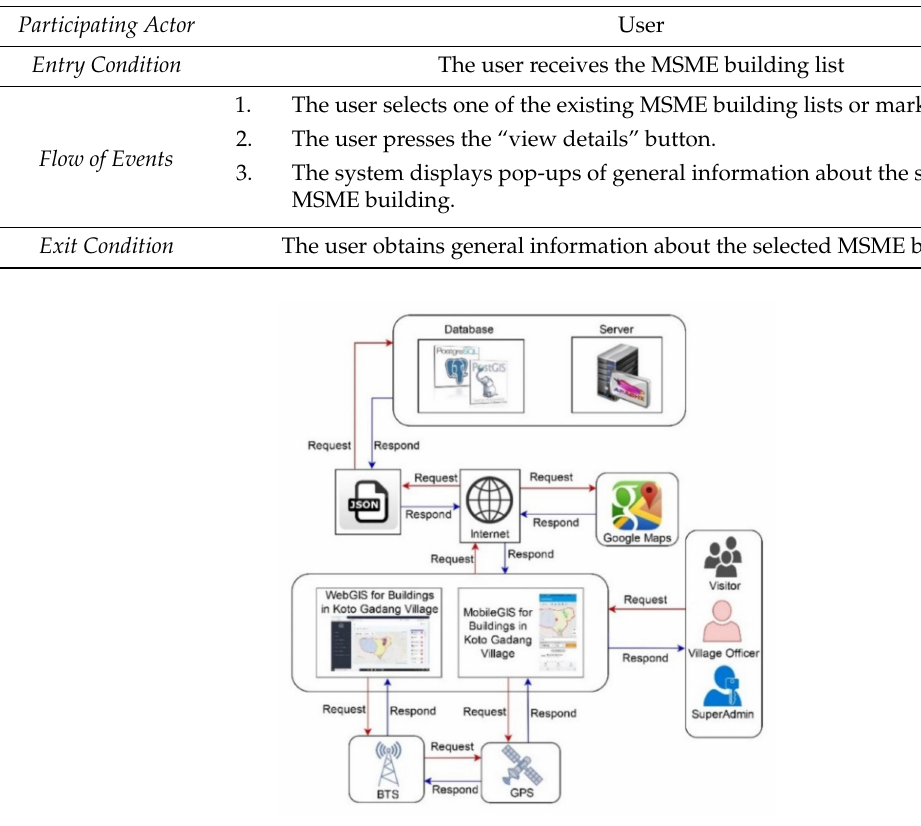
Figure 8. The system architecture diagram of the GIS for buildings